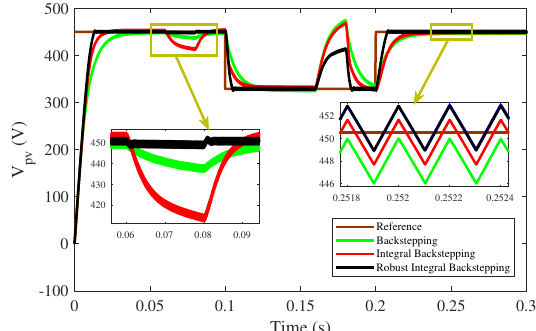
Figure 14. PV array voltage with multiple faults under varying temperature and irradiance.